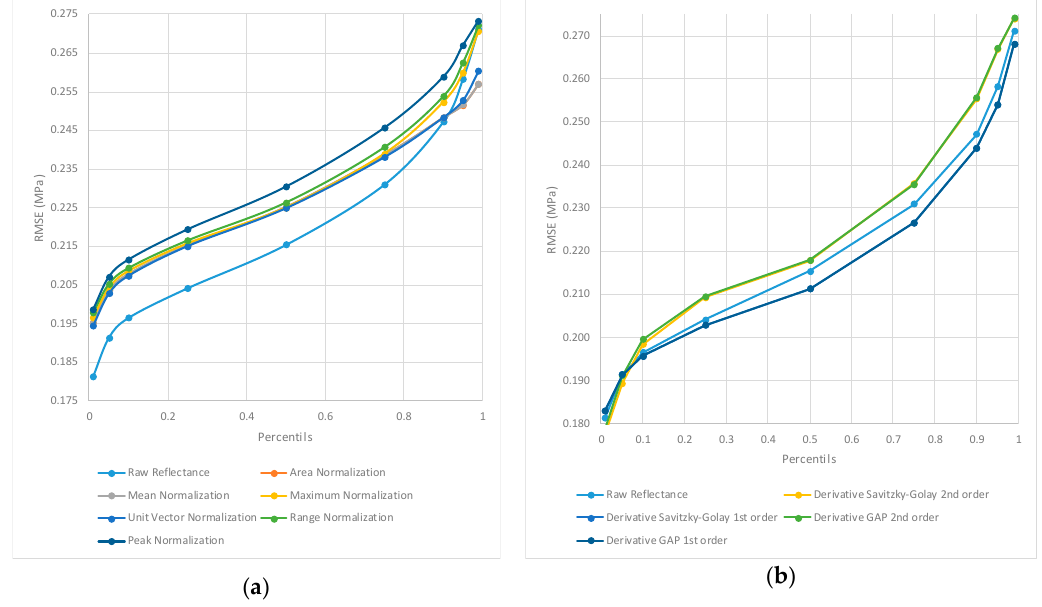
Figure 8. Maximum errors ordered by RMSE percentile from lowest to highest. The lower curves show a higher number of correlations with lower residuals. ( a ) Raw reflectance versus normalization pre-processing. ( b ) Raw reflectance versus derivative pre-processing.